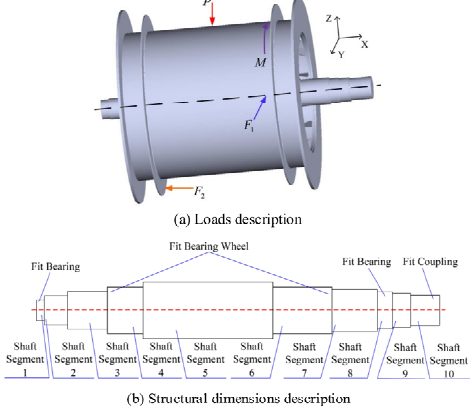
Figure 6. Main shaft device of a multi ‐ layer winding mine hoist for Example 3.